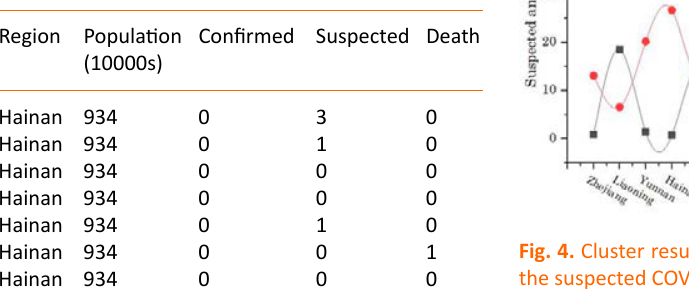
Table 6. Evidence from Primary Data Set for Hainan Region claims Suspected Covid-19 cases to Death cases without getting Confirmed.